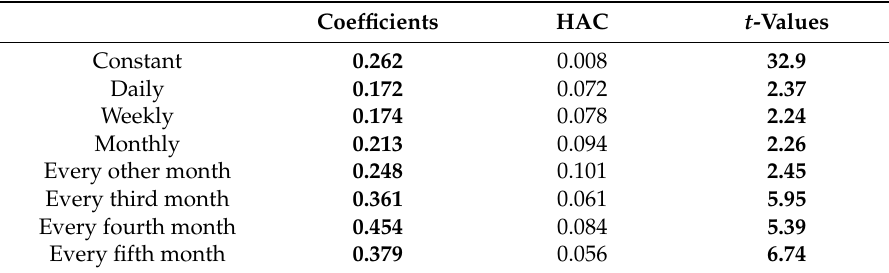
Table 12. OLS estimates from Equation (5) (bold denotes